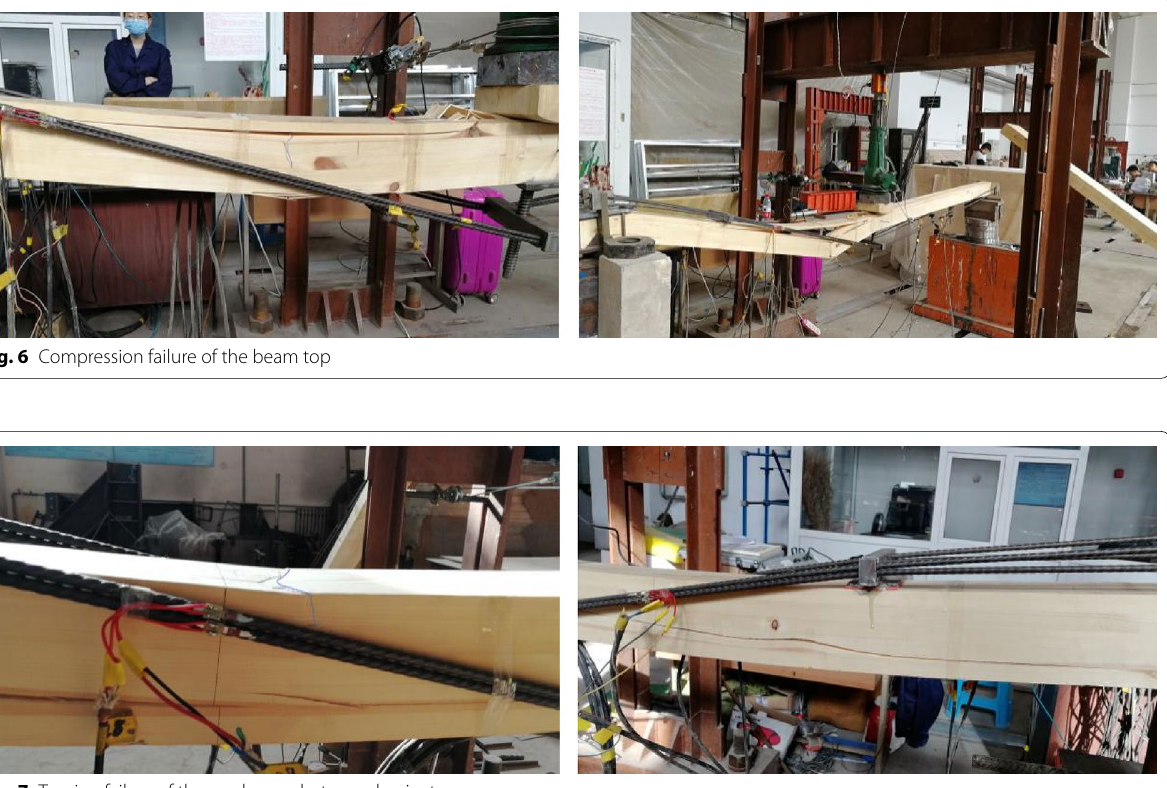
Fig. 7 Tension failure of the weak areas between